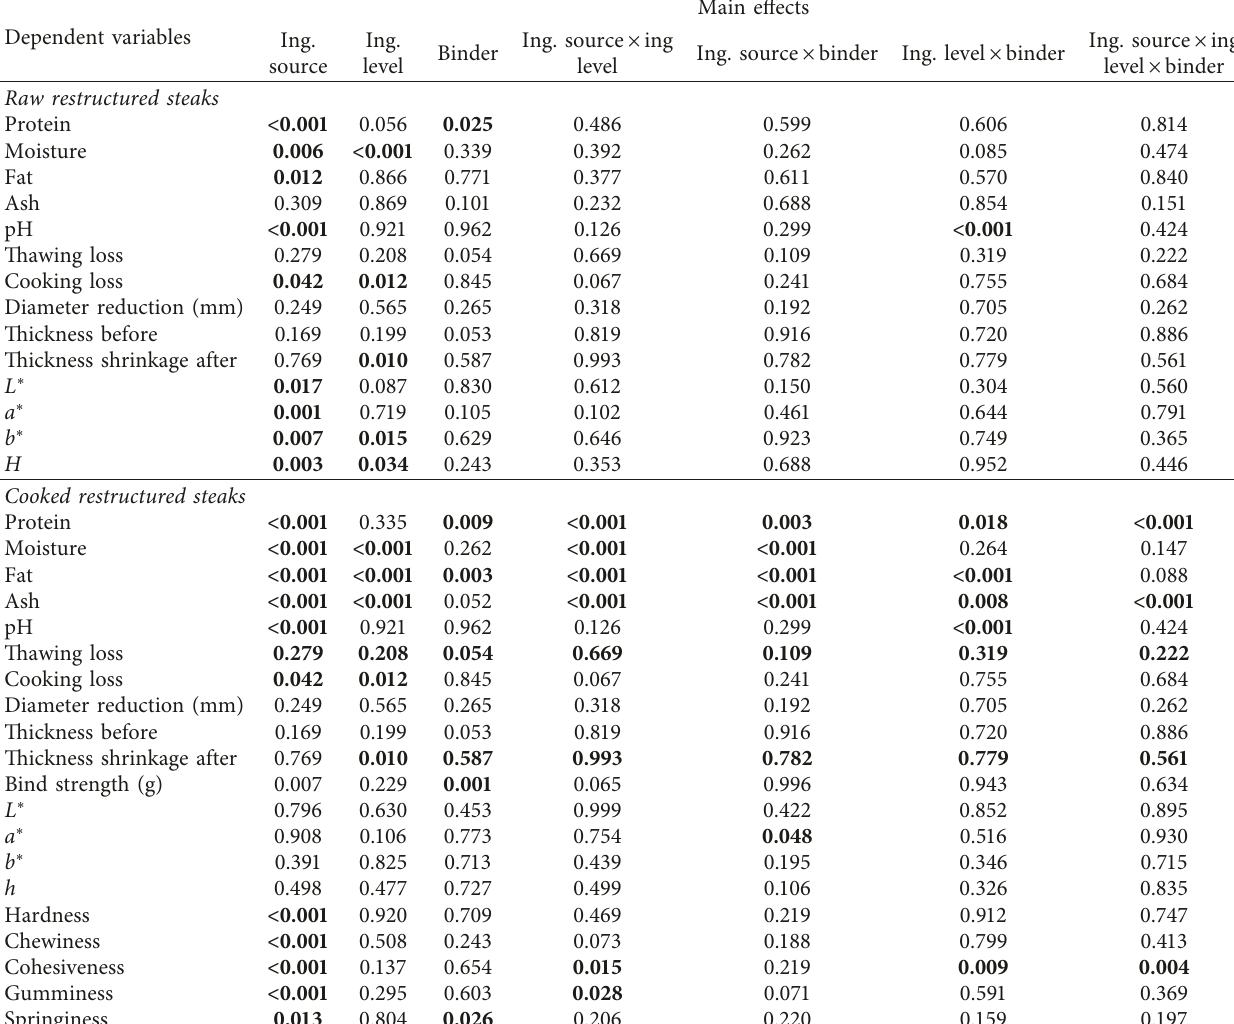
Table 2: P values from ANOVA for the dependent variables (excluding control) for main effects and interactions. Dependent